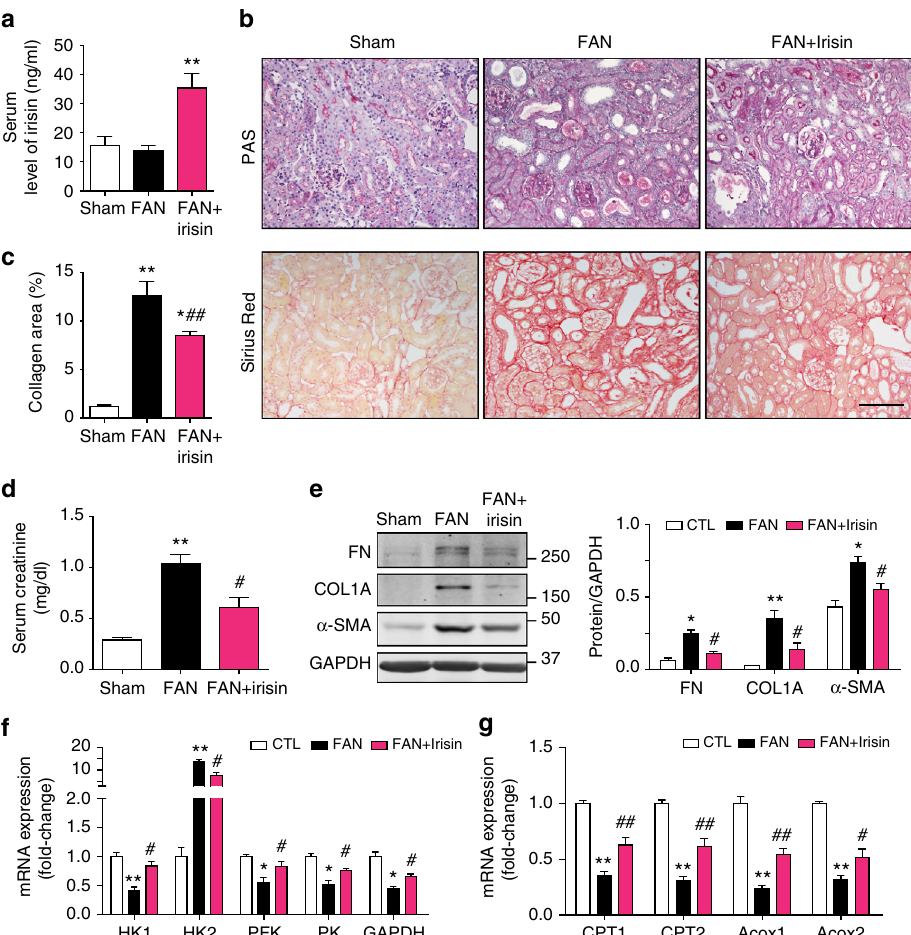
Fig. 7 Recombinant irisin administration ameliorated renal fi brosis in FAN mice. a Irisin injection (200 μ g kg − 1 , ip daily for 2 weeks) achieved > 2 folds increase in serum ( ** P < 0.01 for FAN + irisin vs. Sham or FAN group, n = 5 per group, one-way ANOVA with Bonferroni ’ s multiple comparison test). b Representative images of PAS staining showing less tubule dilation, atrophy and brush-board loss in FAN mice treated with recombinant irisin. c Sirius red staining revealing collagen deposition decreased in FAN mice treated with irisin. Quantitative analysis of interstitial collagen in different groups as indicated. ** P < 0.01 for FAN vs. Sham, * P < 0.05 for FAN + irisin vs. FAN, and ## P < 0.01 for FAN + irisin vs. Sham. Data was presented as mean ± s.e.m. ( n = 5 per group, one-way ANOVA with Bonferroni ’ s multiple comparison test). Scale bars, 100 μ m. d Kidney function (serum creatinine) was assessed in FAN mice after irisin treatment. e : Western blots showing fi brotic protein expression in kidneys from FAN mice treated with irisin. Quantitative measurements of Fibronectin (FN), Collagen 1A and α -SMA protein expression in kidneys from each group as indicated. * P < 0.05 or ** P < 0.01 for FAN vs. Sham and # P < 0.05 for FAN + irisin vs. FAN ( n = 5 per group, one-way ANOVA with Bonferroni ’ s multiple comparison test). f and g Real-time qPCR analysis of enzymes expression in glycolysis f and fatty acid oxidation g pathway. Data were presented as mean ± s.e.m.; * P < 0.05 or ** P < 0.01 for FAN vs. Sham and # P < 0.05 for FAN + irisin vs. FAN ( n = 5 per group, one-way ANOVA with Bonferroni ’ s multiple comparison test) respectively 22 . Treatment of R1B cells (lacking functional suppressed TGF- β 1-stimulated phosphorylation of Smad2/3 in tubule cells (Fig. 6c, left panel). We also con fi rmed that irisin TGFBR1) with irisin or TGF- β 1 produced ERK1/2 phosphoryla- intensi fi ed TGF- β 1-induced phosphorylation of ERK and p38 tion but did not increase the phosphorylation of Smad2/3. (Fig. 6c, right panel). On the basis of these results, we speculate Notably, the combination of TGF- β 1 plus irisin enhanced ERK1/2 that irisin interacts with TGFBR2 — synergistically stimulating phosphorylation (Fig. 6d, middle panel). In contrast, neither ERK signaling — and that it simultaneously inhibits the recruit- TGF- β 1 nor irisin phosphorylated ERK1/2 or Smad2/3 in R26G ment of TGFBR1 to TGFBR2, therefore impeding Smad2/3 cells, which contain a nonfunctional TGFBR2 (Fig. 6d, right phosphorylation. panel). These results indicate that irisin stimulates ERK TGF- β 1 interacts with the TGF- β type-2 receptor (TGFBR2) to phosphorylation by functionally activating TGFBR2. recruit and activate the TGF- β type-1 receptor (TGFBR1) 19 . Using confocal microscopy, we detected that FITC-labeled Active TGFBR1 phosphorylates and activates canonical, Smad2/ irisin co-localized with TGFBR2 in primary cultures of tubule 3-medicated signaling 19 , while TGFBR2 activates signaling path- cells, thereby indicating interaction between irisin and TGFBR2 ways, including TAK1, ERK1/2, and p38 20,21 . To understand the (Fig. 6e). To test whether irisin interacts with TGFBR2 to inhibit TGF- β 1-induced smad2/3 phosphorylation competitively, we examined the dose-response relationships of TGF- β 1 and irisin in the primary cultures of tubule cells. As shown in Fig. 6f, TGF- β 1 and irisin synergistically stimulated ERK1/2 phosphorylation, NATURE COMMUNICATIONS | 8: 1493 | DOI: 10.1038/s41467-017-01646-6 |